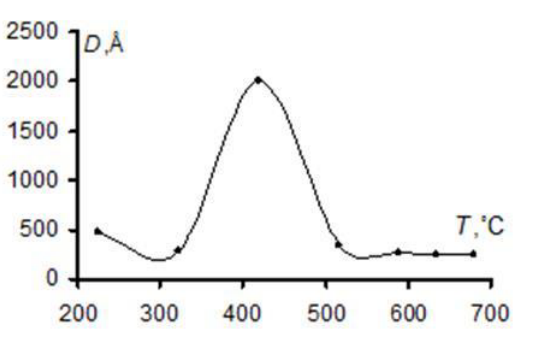
Figure 3. The crystallite size versus temperature (steel